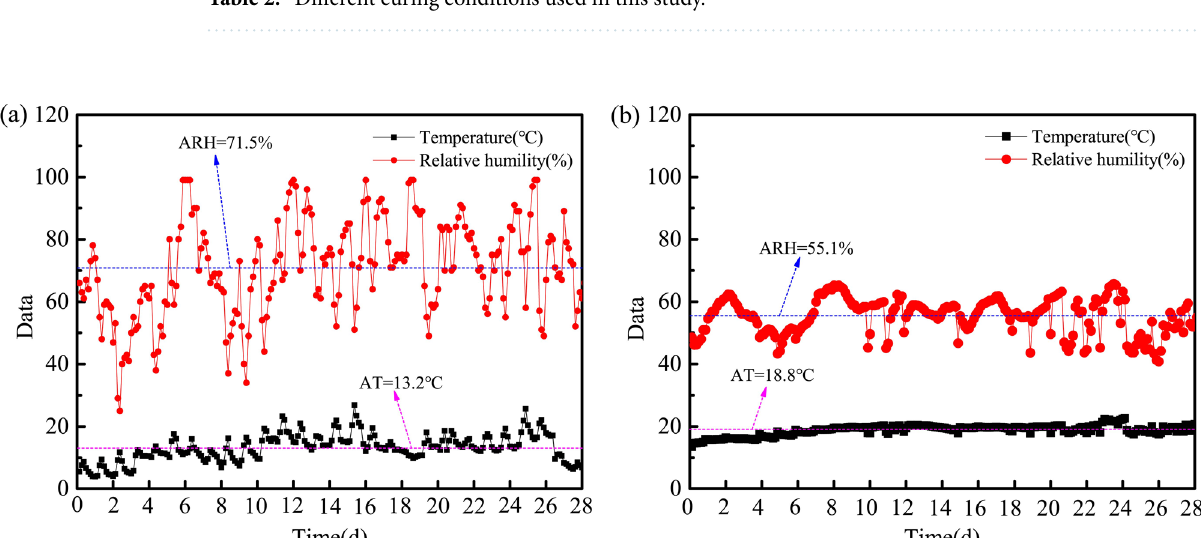
Figure 2. Temperature and relative humidity of the outdoor and indoor cuing environment. ( a ) Outdoor curing condition. ( b ) Indoor curing condition (AT: average temperature, ARH: average relative humidity).